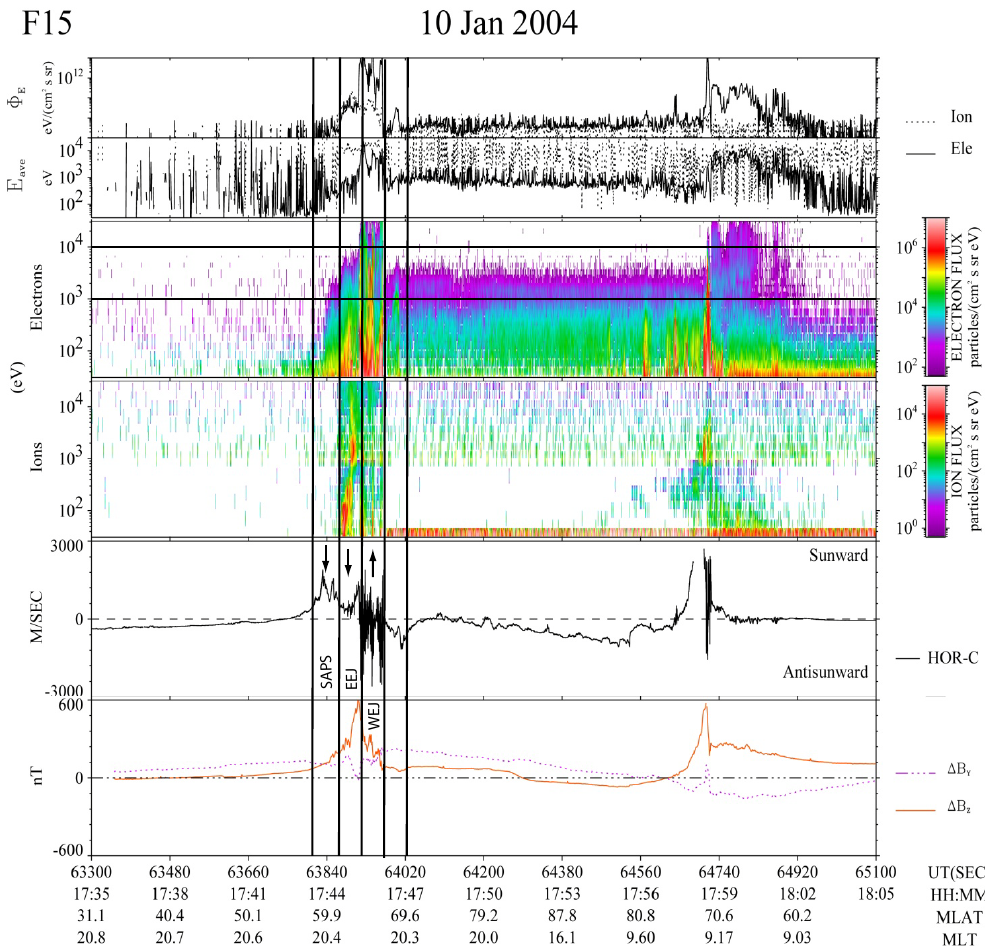
Fig. 12. DMSP F15 data obtained during the interval 17:35–18:05UT. Same format as in Fig. 8. Latitude regimes corresponding to subauroral polarization stream (SAPS), and the eastward and westward electrojets (EEJ and WEJ) have been delimited by vertical guidelines. Field- aligned current directions (R2 in: positive B z gradient; and R1 out: negative B z gradient) are marked in the ion drift panel.